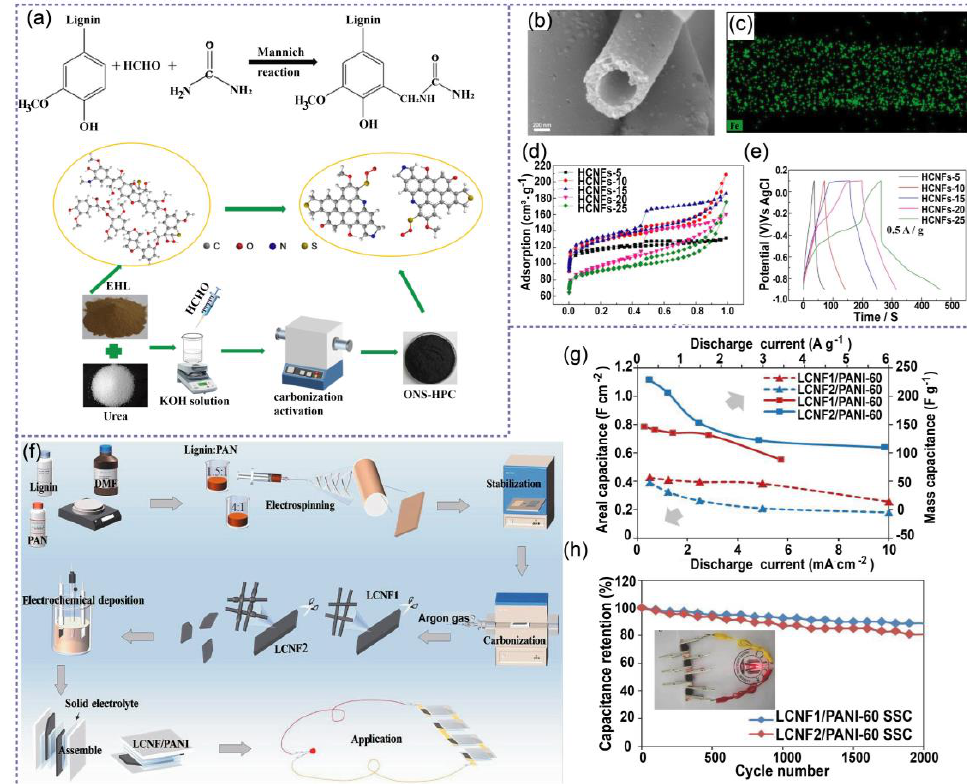
Figure 6. ( a ) The principle of lignin being chemically modified and the preparation process diagram. ( b ) SEM images of HCNFs. ( c ) EDX mapping of Fe element of HCNFs-25. ( d ) N 2 adsorption/desorption isotherm of HCNFs. ( e ) GCD curves of HCNFs at 0.5 A g − 1 . ( f ) Manufacturing process of LCNF/PANI hybrid electrodes. ( g ) Specific capacitances of LCNF/PANI supercapacitors at different current densities. ( h ) Cyclic stability of LCNF/PANI supercapacitors (From Refs. [90 – 92]).